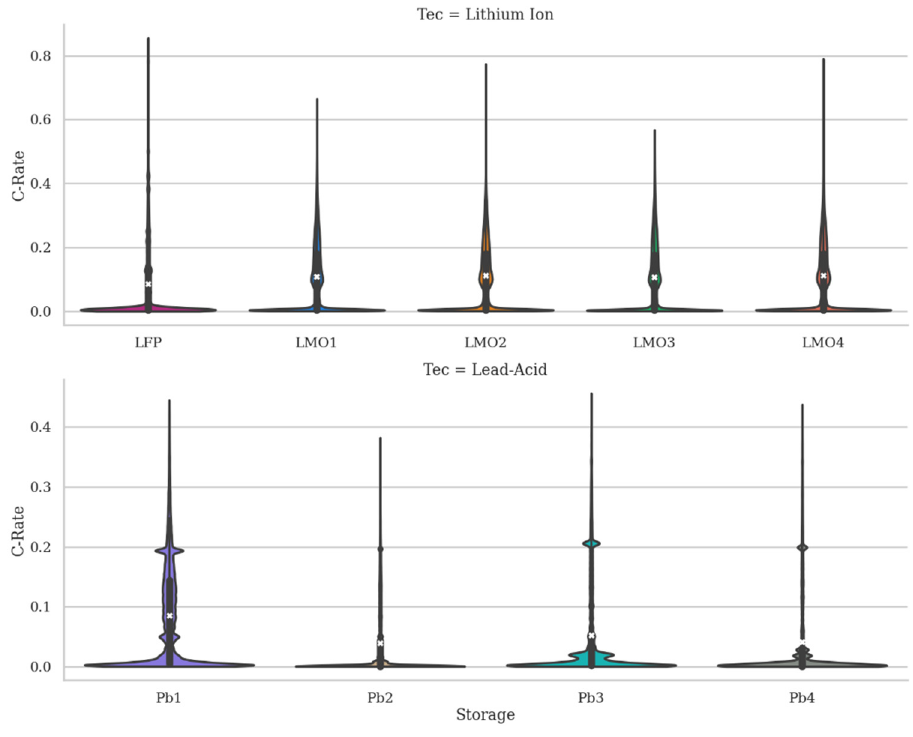
Figure 10. Distribution of C-rate for the different battery units.